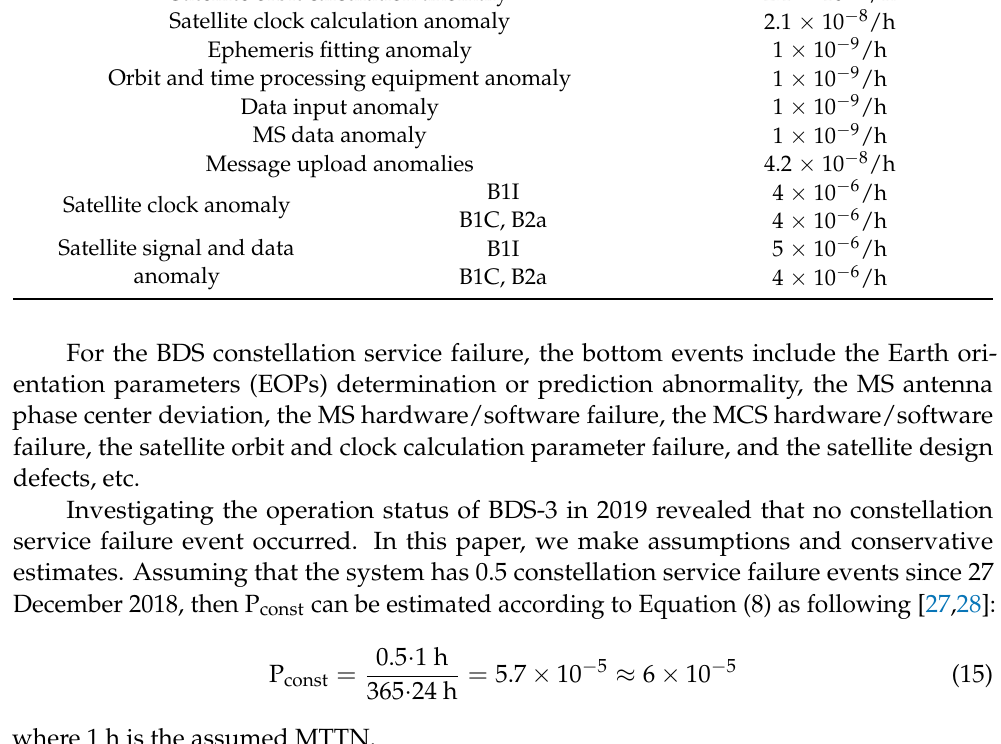
all the bottom events in Table 3. For the B1I signal, the design P sat is 0.9 × 10 − 5 /h; for the